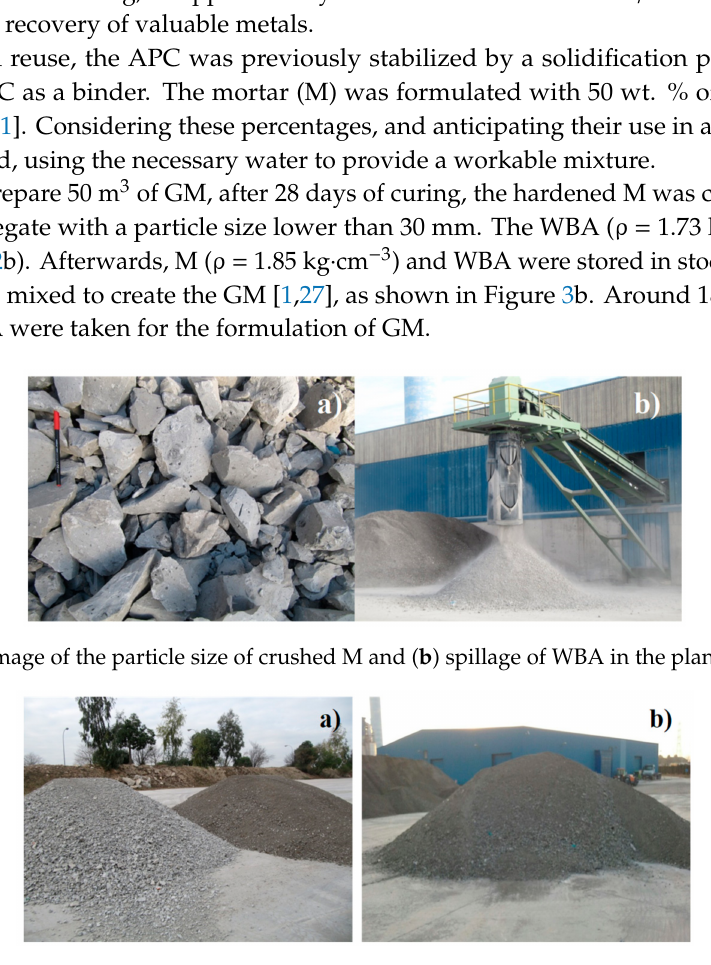
Figure 3. ( a ) Crushed M ( grey ) and WBA ( dark ) stockpiles ( b ) GM obtained from the mixture between 80 wt. % WBA and 20 wt. % crushed